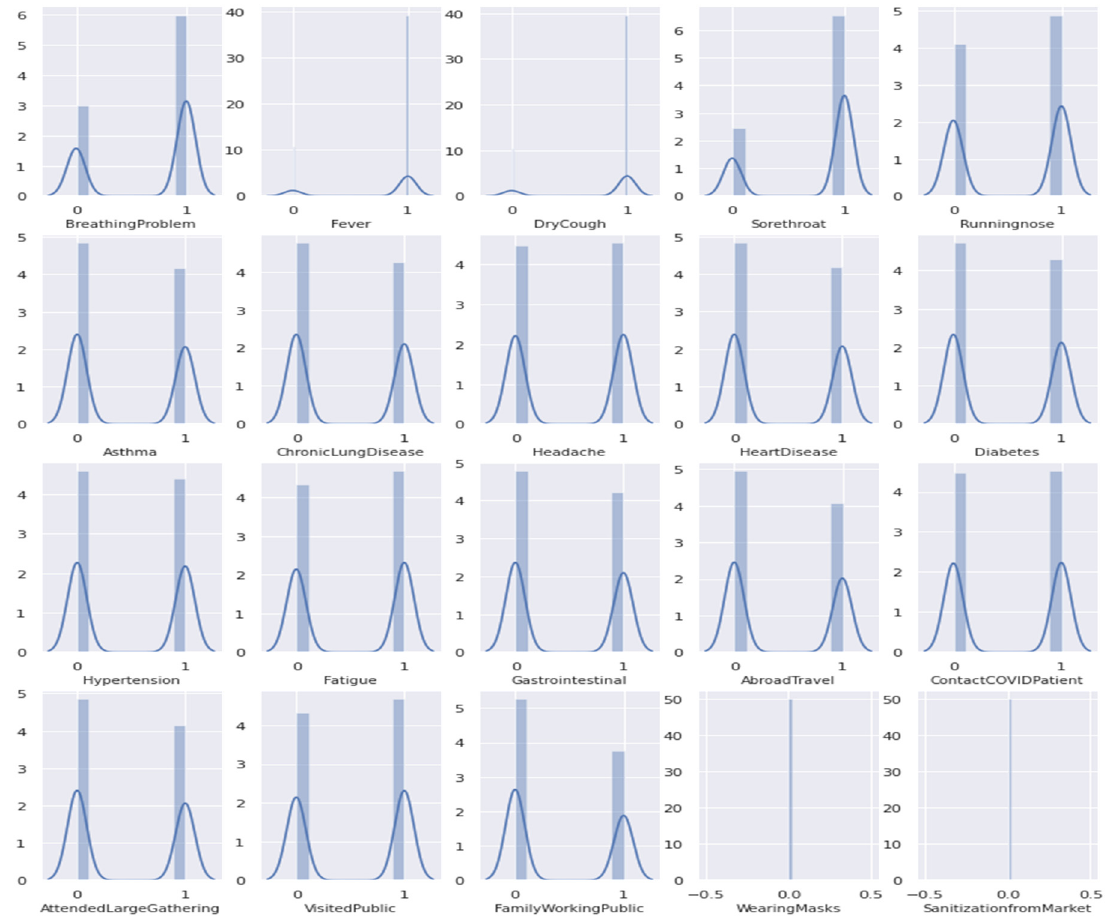
Figure 2. The distplot of the collected